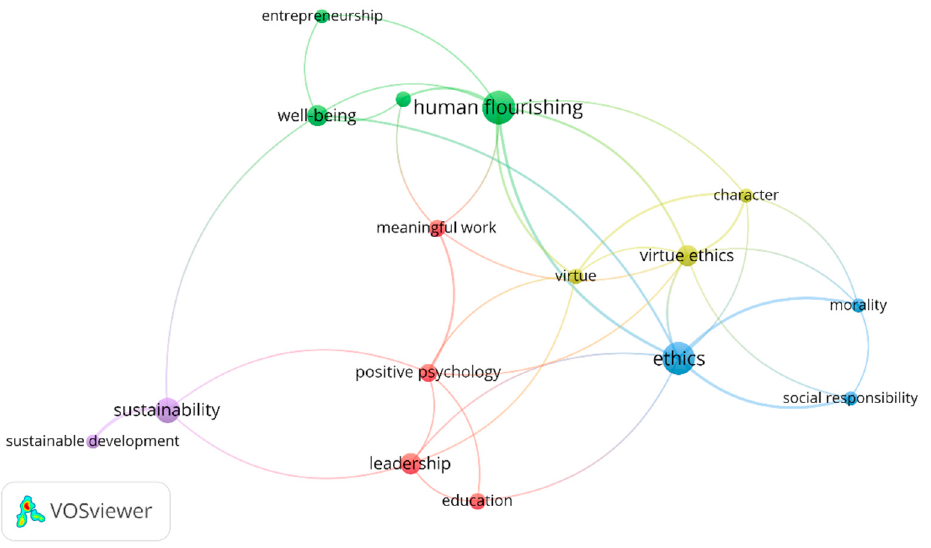
Figure 4. Network visualization (human flourishing—SCOPUS).